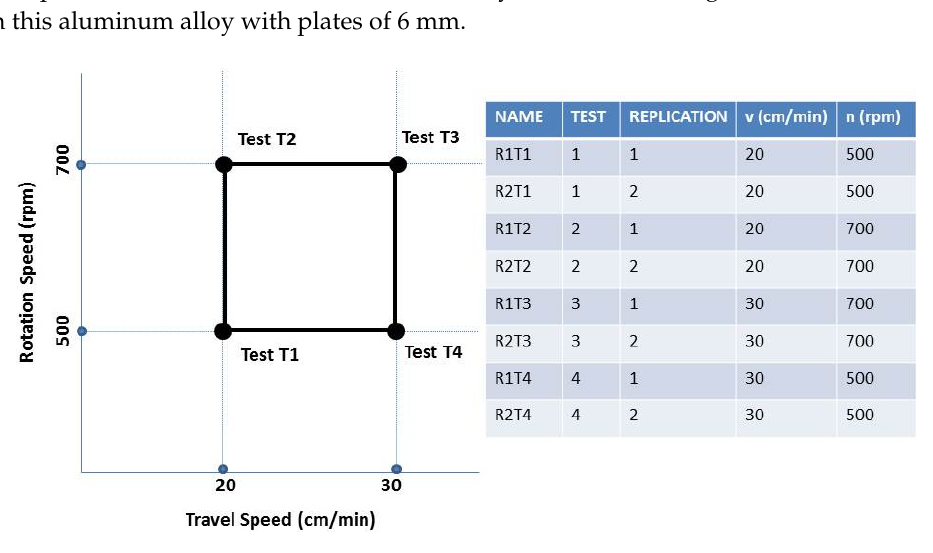
Figure 3. Full Factorial Plane 2 2 .